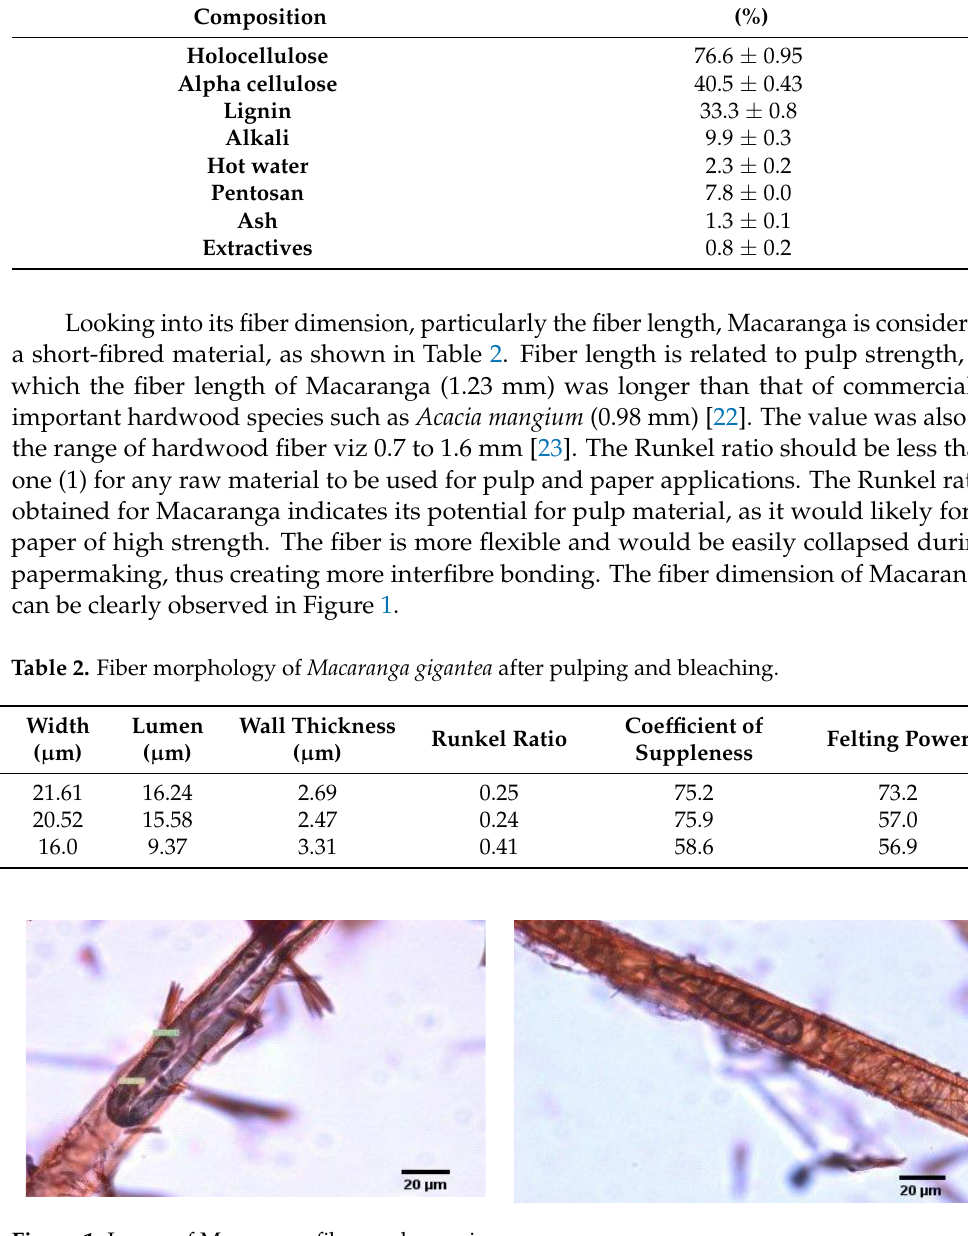
Figure 1. Image of Macaranga fiber under a microscope.